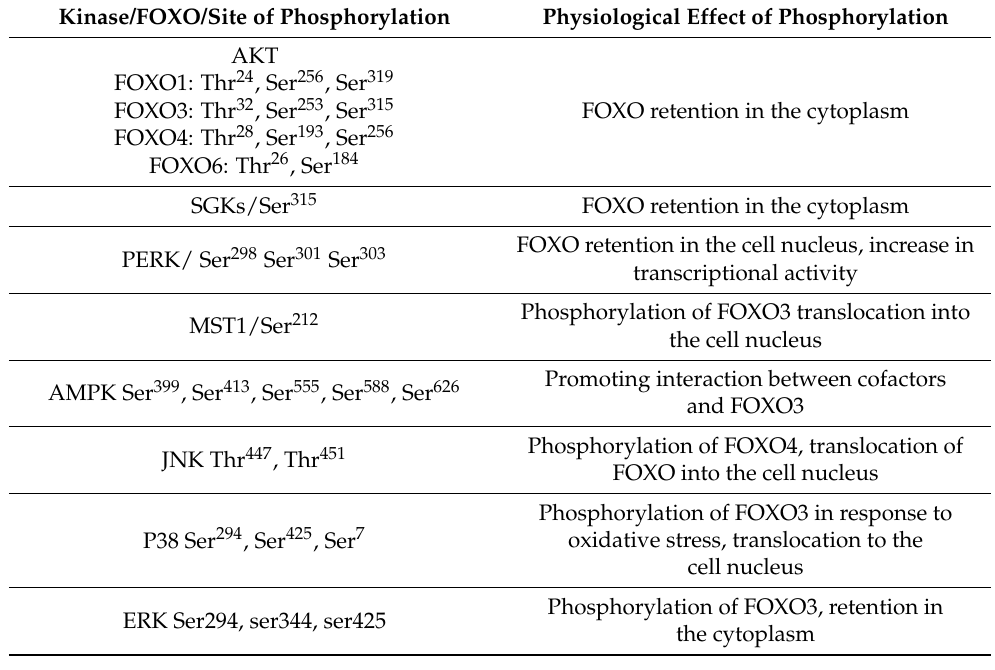
Table 1. Short characteristics of FOXO